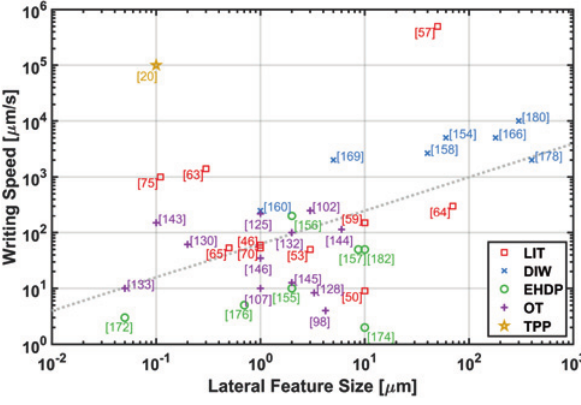
Figure 1: Feature size vs. writing speed for laser induced transfer (LIT), direct ink writing (DIW), electrohydrodynamic printing (EHDP), optical tweezers (OT), and two photon polymerization (TPP). Optical tweezers belong to the class of light directed assembly techniques, while direct ink writing and electrohydrodynamic printing are subcategories of inkjet printing. The dotted line is the best fit line of all the data points (excluding TPP), illustrating the positive correlation between feature size and writing